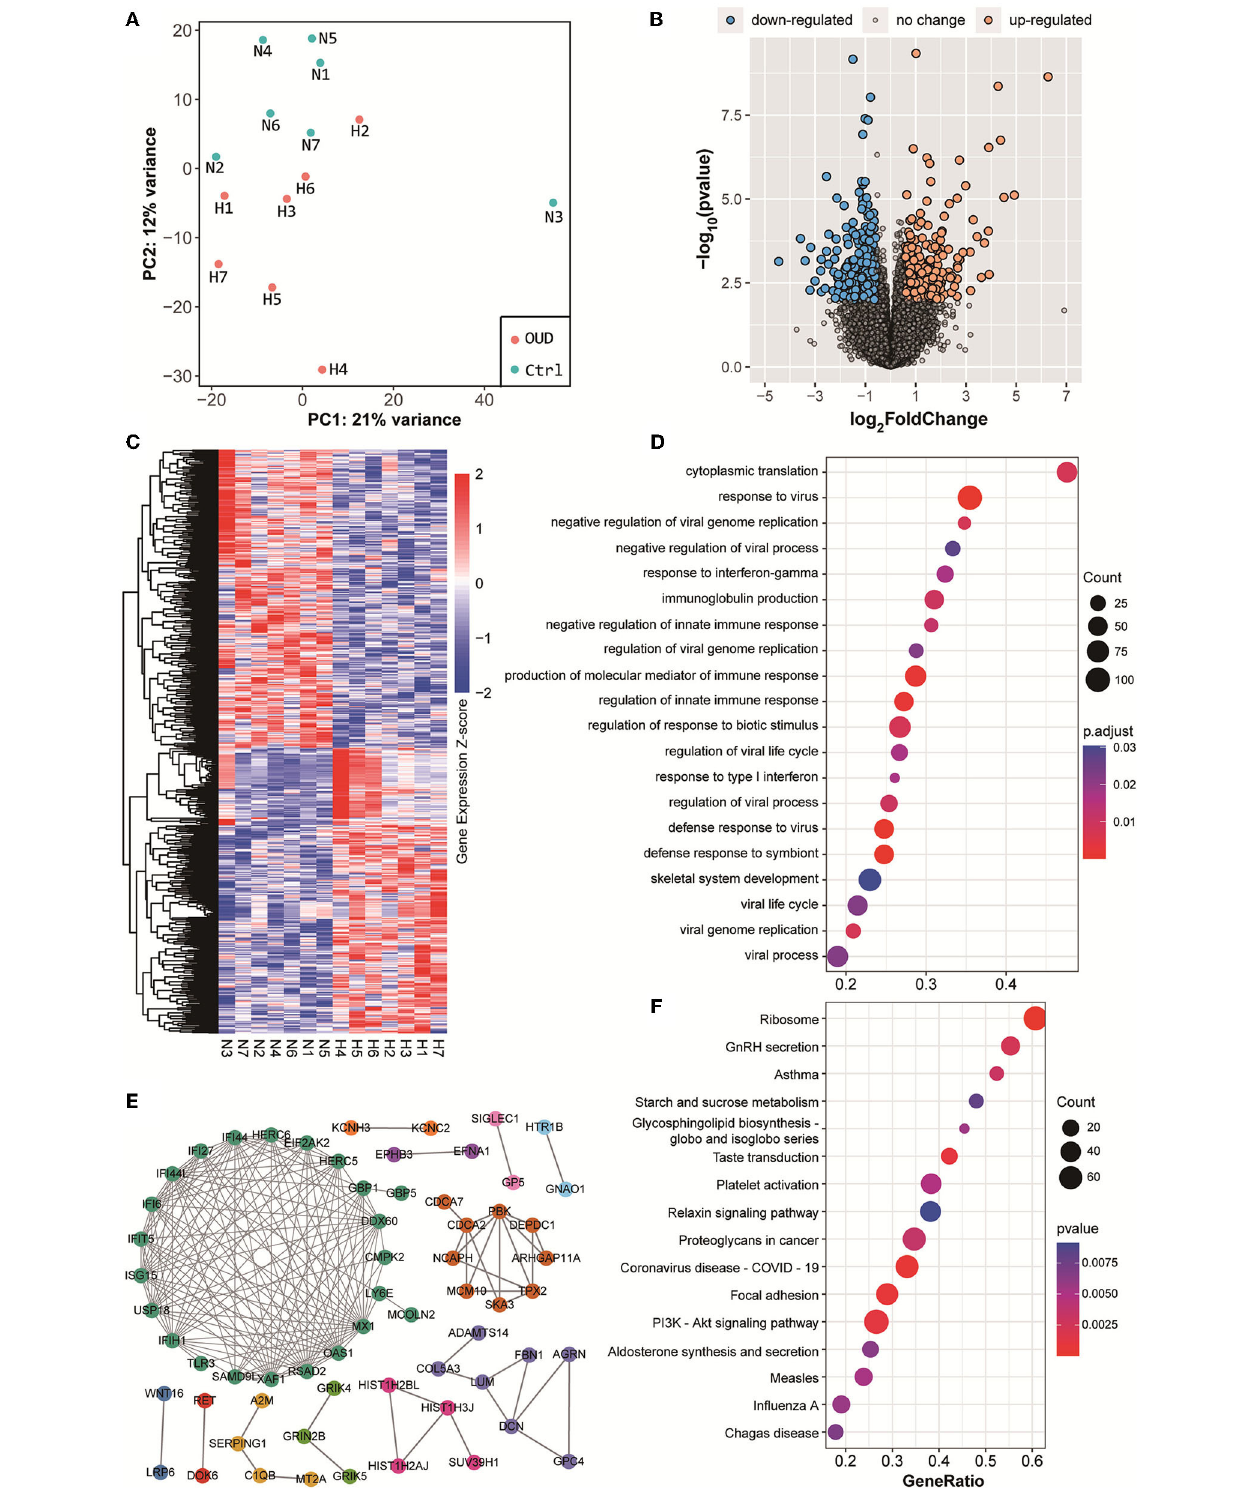
FIGURE 1 | Results of rRNA removed RNA-seq. (A) Principal component analysis results of all samples. The red dot in the figure represented the OUD group and blue dot represented the control group. (B) Volcano plot of all expressed genes. We set the threshold of differential expression as |log 2 FoldChange| > 1.5 & p -value < 0.01. The blue dot, orange dot and gray dot represented the down-regulated genes (OUD/Control), up-regulated genes and non-significant changed genes,